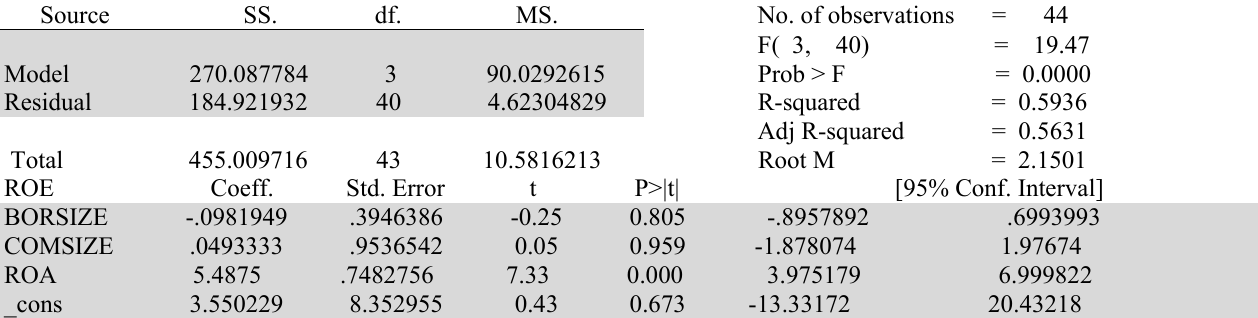
Fig. 2. The results of Pearson correlation test between board size and ROE The results of ANOVA test and regression analysis